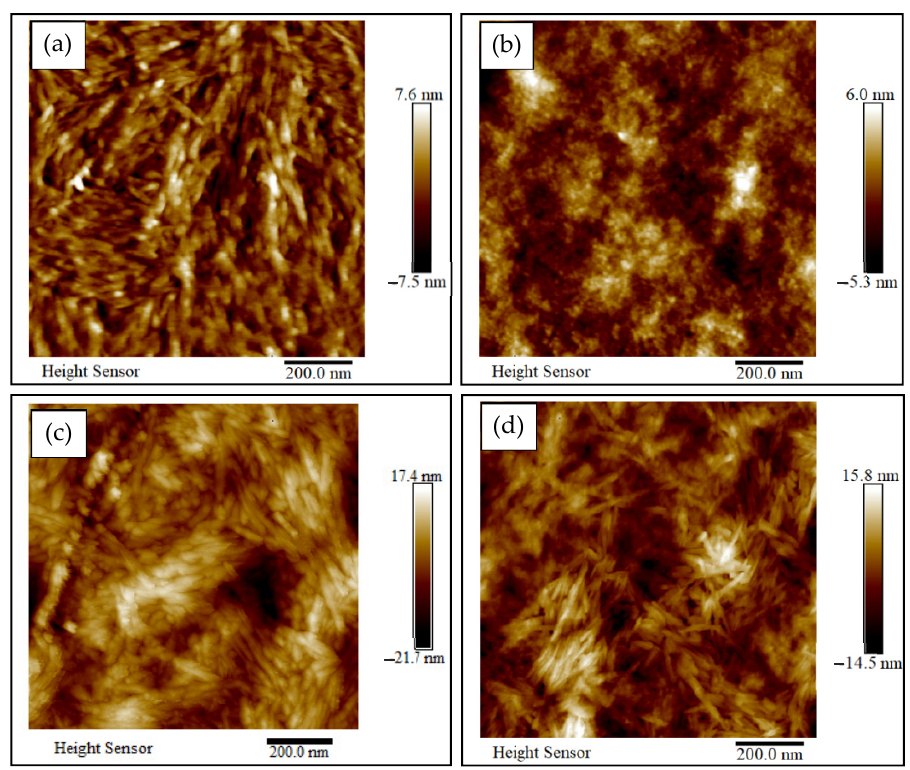
Figure 3. AFM topographic images in 2D of ( a ) NCC, ( b ) PEDOT, ( c ) NCC/PEDOT (before), and ( d ) NCC/PEDOT (after) thin films.